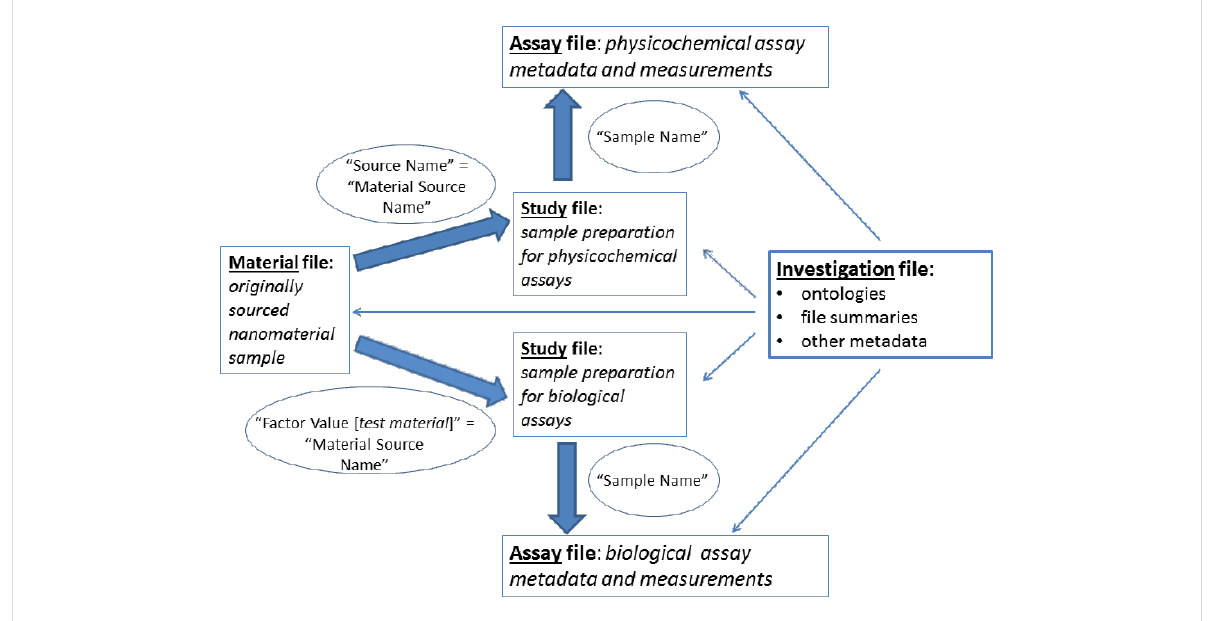
Figure 1: A schematic illustration of the links between ISA-TAB-Nano files. Biological or material samples are prepared for measurements in bio- logical or physicochemical assays respectively. Assay files link measurement values with prepared sample identifiers (“Sample Name” values). Study files describe sample preparation. Material files describe the nanomaterials obtained for testing, denoted via their “Material Source Name” identifiers. N.B. Italic font denotes generic names, e.g., “Factor Value [ test material ]” is replaced with “Factor Value [nanomaterial]” in the NanoPUZZLES in vitro cell-based Study file